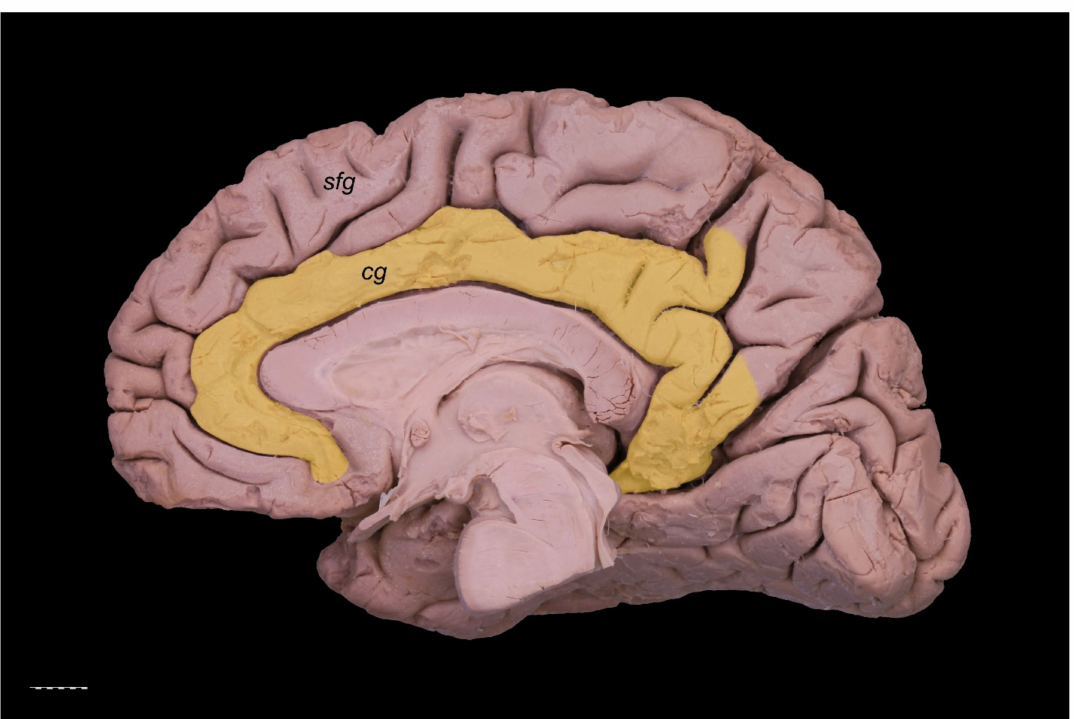
Figure 1. Absence of the PCG. The cingulate gyrus is marked pale yellow. Medial view of the right cerebral hemisphere. cg—cingulate gyrus; sfg—superior frontal gyrus. Scale bar corresponds to 10